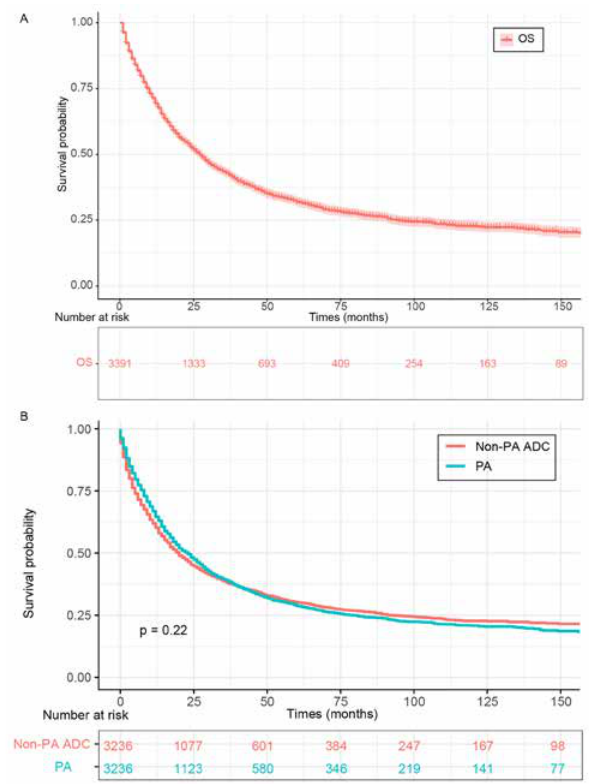
Figure 1: OS for primary pulmonary PA patients. (A) total OS for pul- monary PA patients. (B) OS comparison between primary pulmonary PA and matched non-PA lung